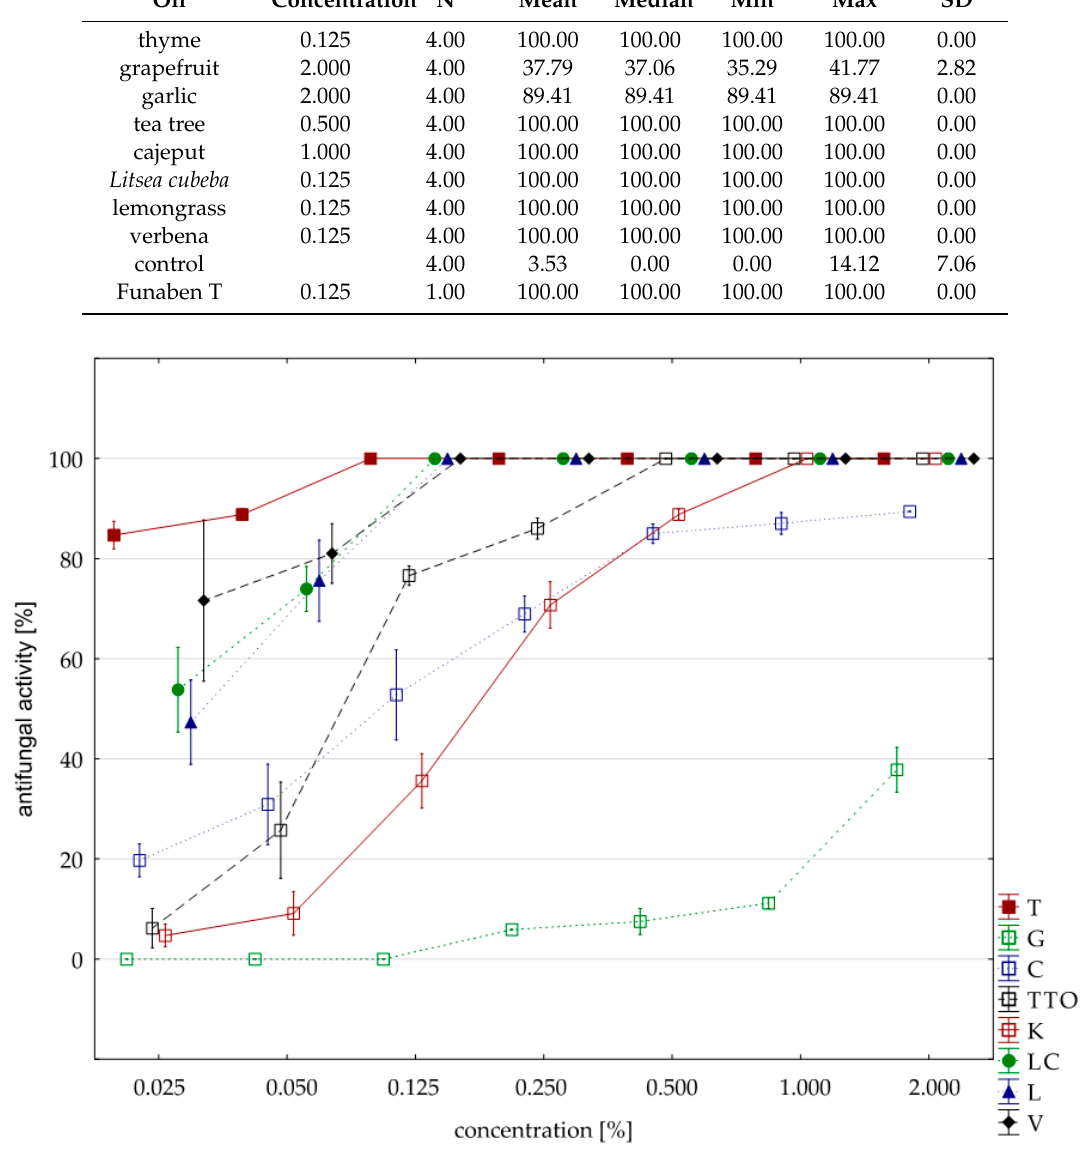
Figure 5. Plot of antifungal activity vs concentration for F. oxysporum .